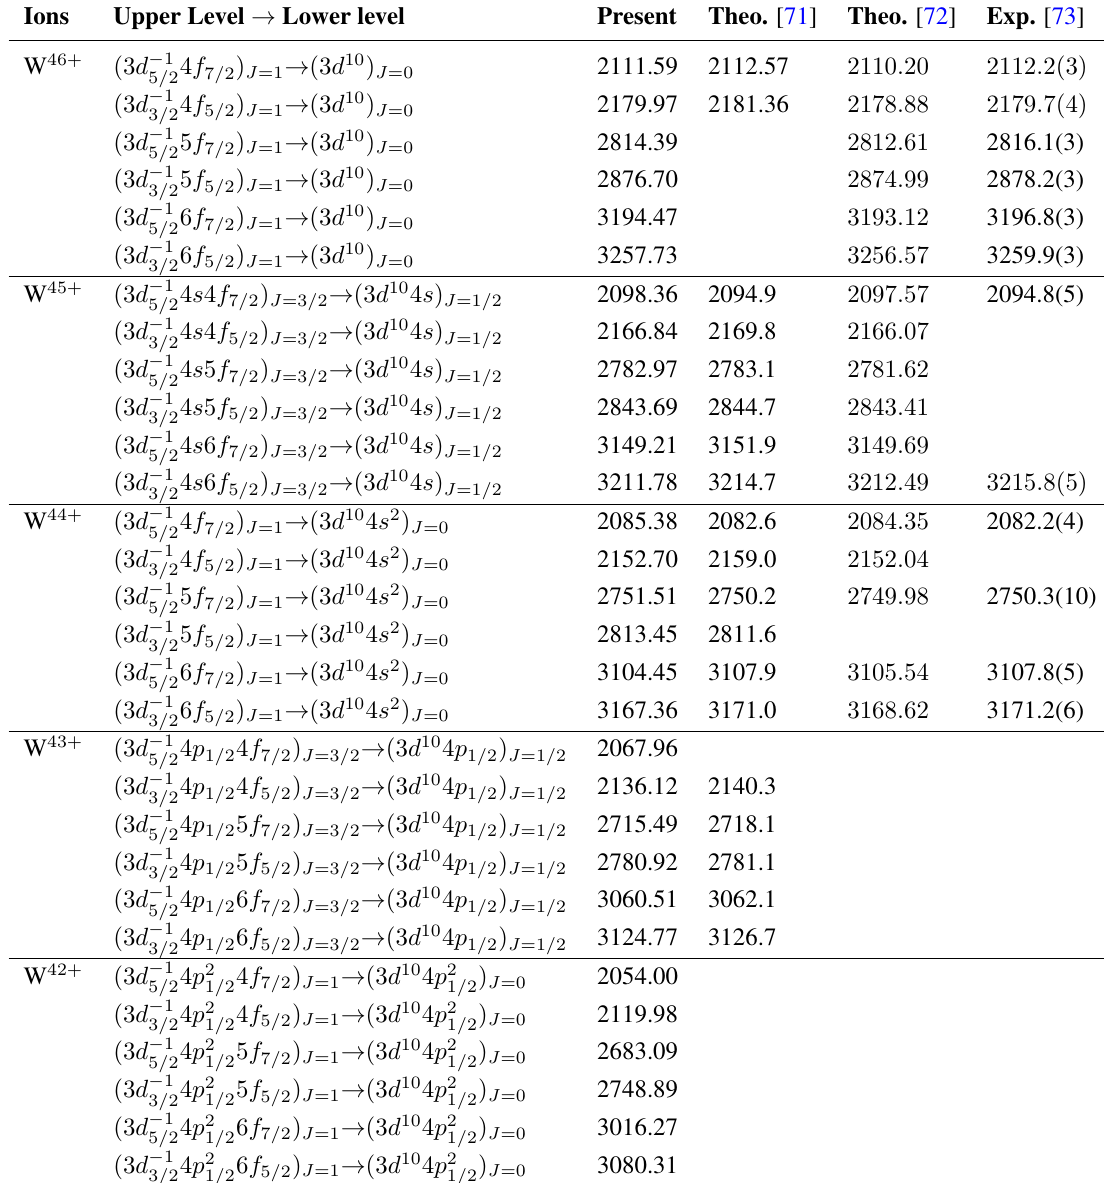
Table 1. The presently calculated excitation energies (eV) for electron-impact excitations 3 d → nf ( n = 4, 5, 6) of W 46+ –W 42+ ions together with other available theoretical and experimental results. Note that closed inner-subshells have been omitted from the upper and lower levels for the sake of brevity. Experimental errors are given in the